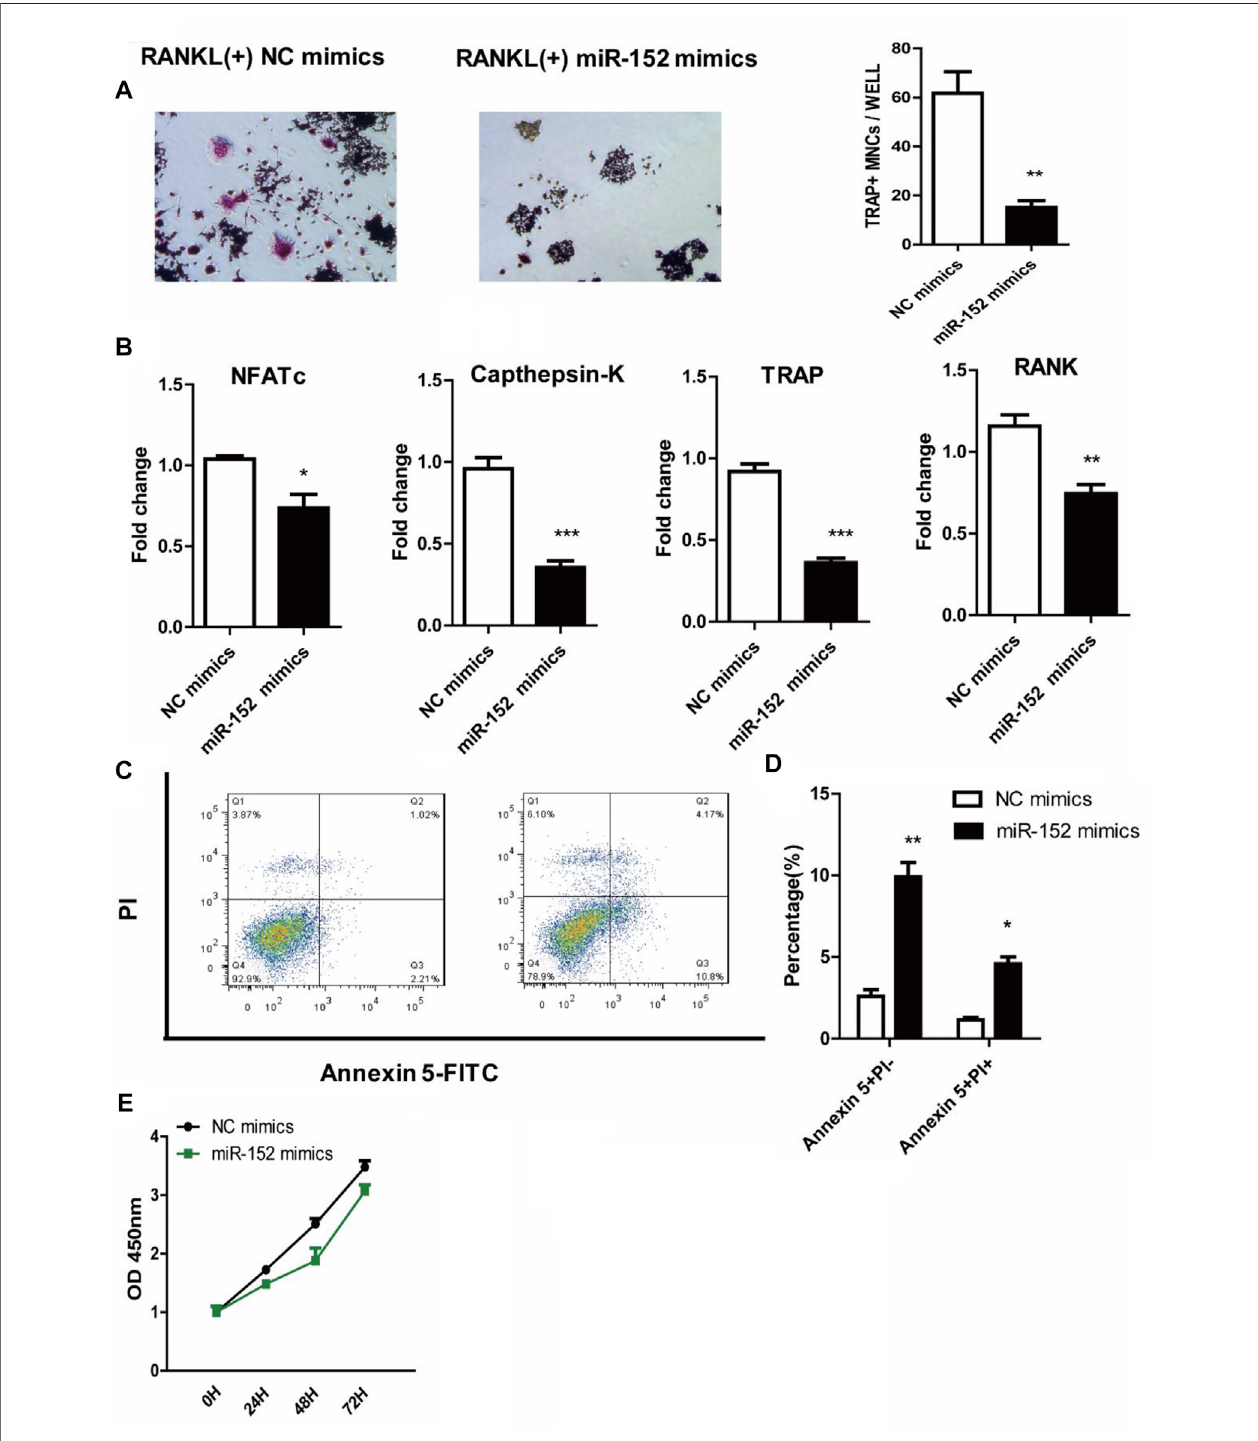
FIGURE 5 | miR-152 inhibits the RANKL-induced osteoclast differentiation in RAW 264.7 cells (A) Representative images and quanti fi cation of RANKL-induced osteoclasts transfected with NC mimics or miR-152 mimics were analyzed for TRAP + cells, Magni fi cation: 100* (B) RT-qPCR analysis of osteoclast differentiation- relatedgenes(NFATc1,CathepsinK,TRAP,andRANK)expressioninmatureosteoclaststransfectedwithNCmimicsormiR-152mimics (C) AfterstainingwithAnnexin 5-FITCandpropidiumiodide(PI),followedbyanalysisusinga fl owcytometer.EarlyapoptoticcellswereAnnexin5 + andPI − andlateapoptoticcellswereAnnexin5 + and PI + (D) Analysis of mature osteoclasts apoptosis transfected with NC mimics or miR-152 mimics (E) RAW264.7 cells were cultured with M-CSF in the absence or presenceofmiR-152mimicssiRNAfor3 days,theproliferationabilityofearlyosteoclastprecursorswasanalyzedbyCCK-8assay.Barsrepresentthemean±SEM.* p < 0.05, ** p < 0.01, *** p < 0.001. The data are representative of three independent experiments.